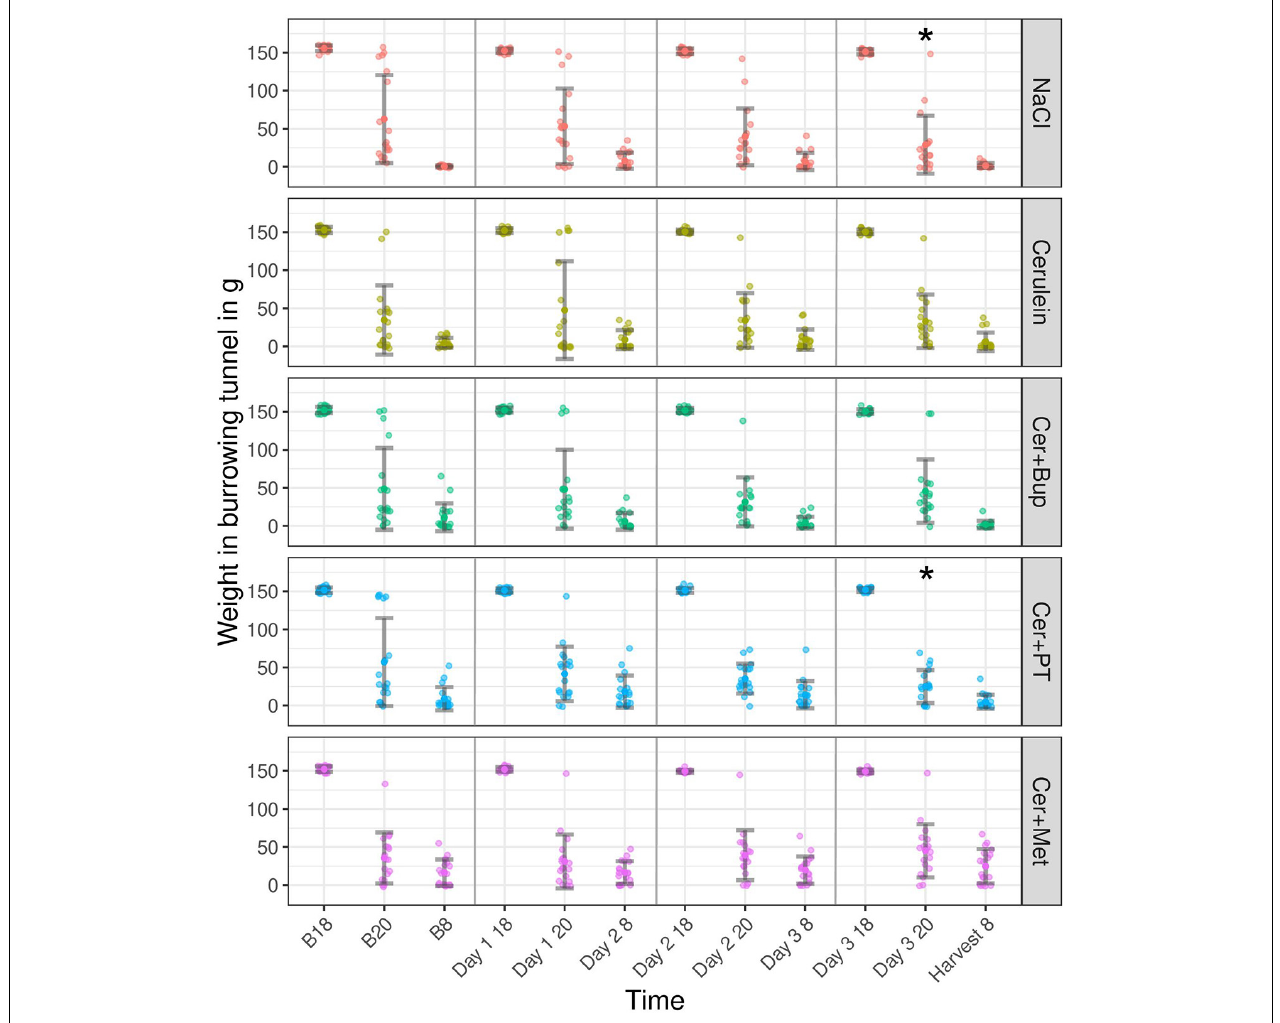
FIGURE 6 | The burrowing behavior displayed as the weight in the burrowing tunnel in grams for baseline (B 18, B 20, and B 8) and experimental days (Day 1, 2, 3, and Harvest). The tunnel weight is shown at the start of the test (B18, Day 1/2/3 18), after 2 h (B 20, Day 1/2/3 20), and after 12 h (B 8, Day 2/3 8, and Harvest 8) for each treatment group. Post hoc testing with Bonferroni correction detected a significantly lower burrowing performance in NaCl compared to Cer and Cer + Met at B20. * Significant ( p ≤ 0.05, Dunnett’s post hoc ) differences to the respective baseline measurements. Data are shown as scatter dot plot with mean ± SD. NaCl n = 18, Cer n = 17, Cer + Bup n = 16, Cer + PT n = 15, Cer + Met n =